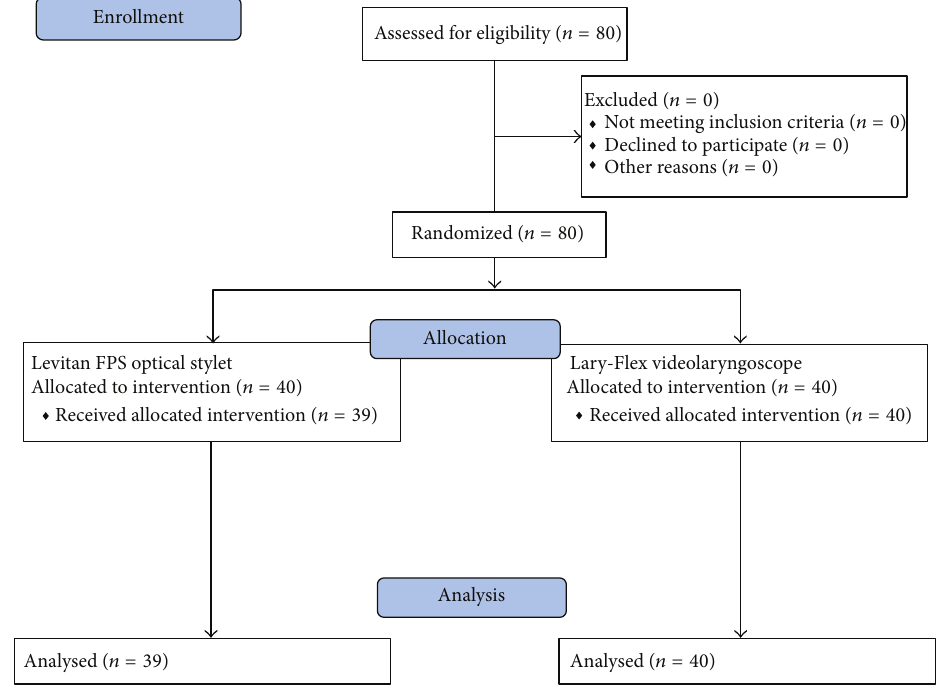
Figure 3: Flow diagram for the study.